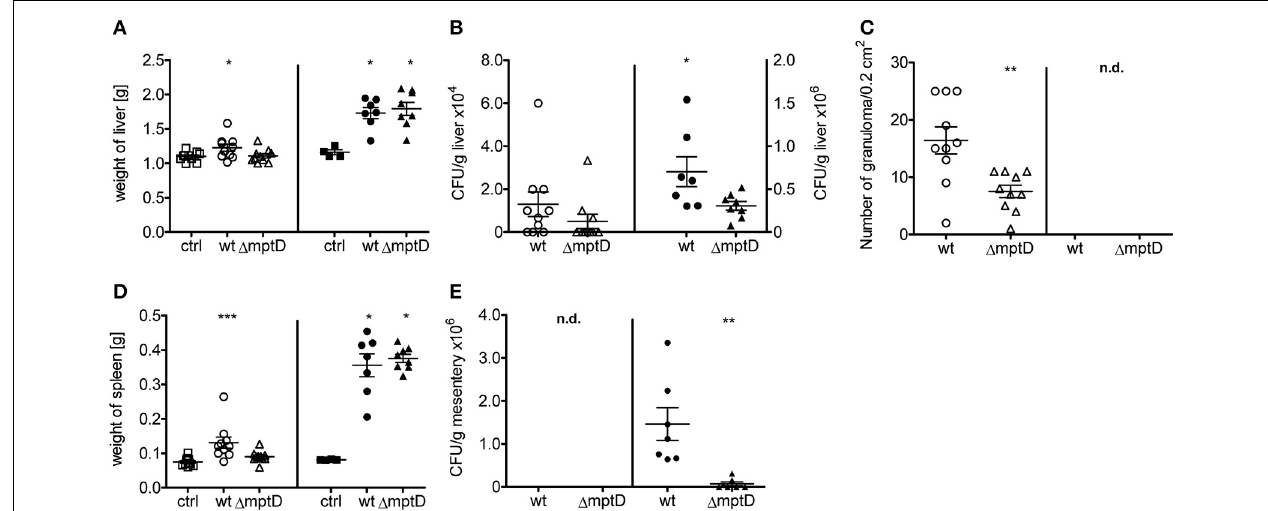
FIGURE 3 | Biological fitness of MAP wild type (MAPwt) and (cid:2) mpt D mutant strain (MAP (cid:2) mpt D) in infected mice. C57BL/6 8 week old female mice were infected with either 1 ∗ 10 8 (open symbols) or 2 ∗ 10 8 cells (black symbols) of MAPwt (circle) and MAP (cid:2) mpt D (triangle) for 4 weeks. DPBS buffer was used for the control group (ctrl, squares). The read out parameters for this experiment were the weight of liver (A) and spleen